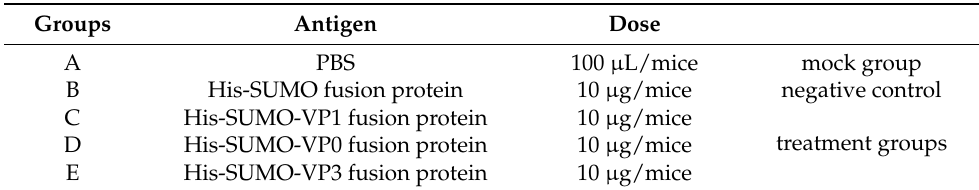
Table 2. The five groups with respect to their immunization materials and doses of injection which were administered through the intramuscular